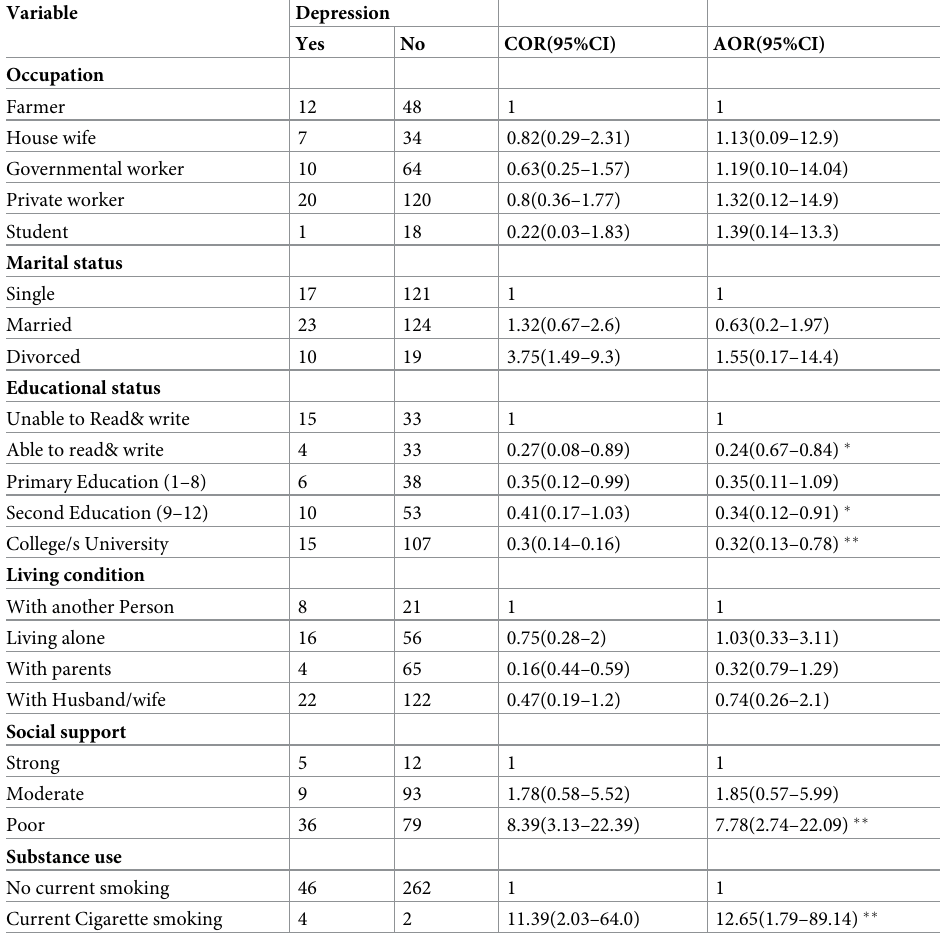
Table 3. Bivariate and multivariate logistic analyses results of study subjects (n =